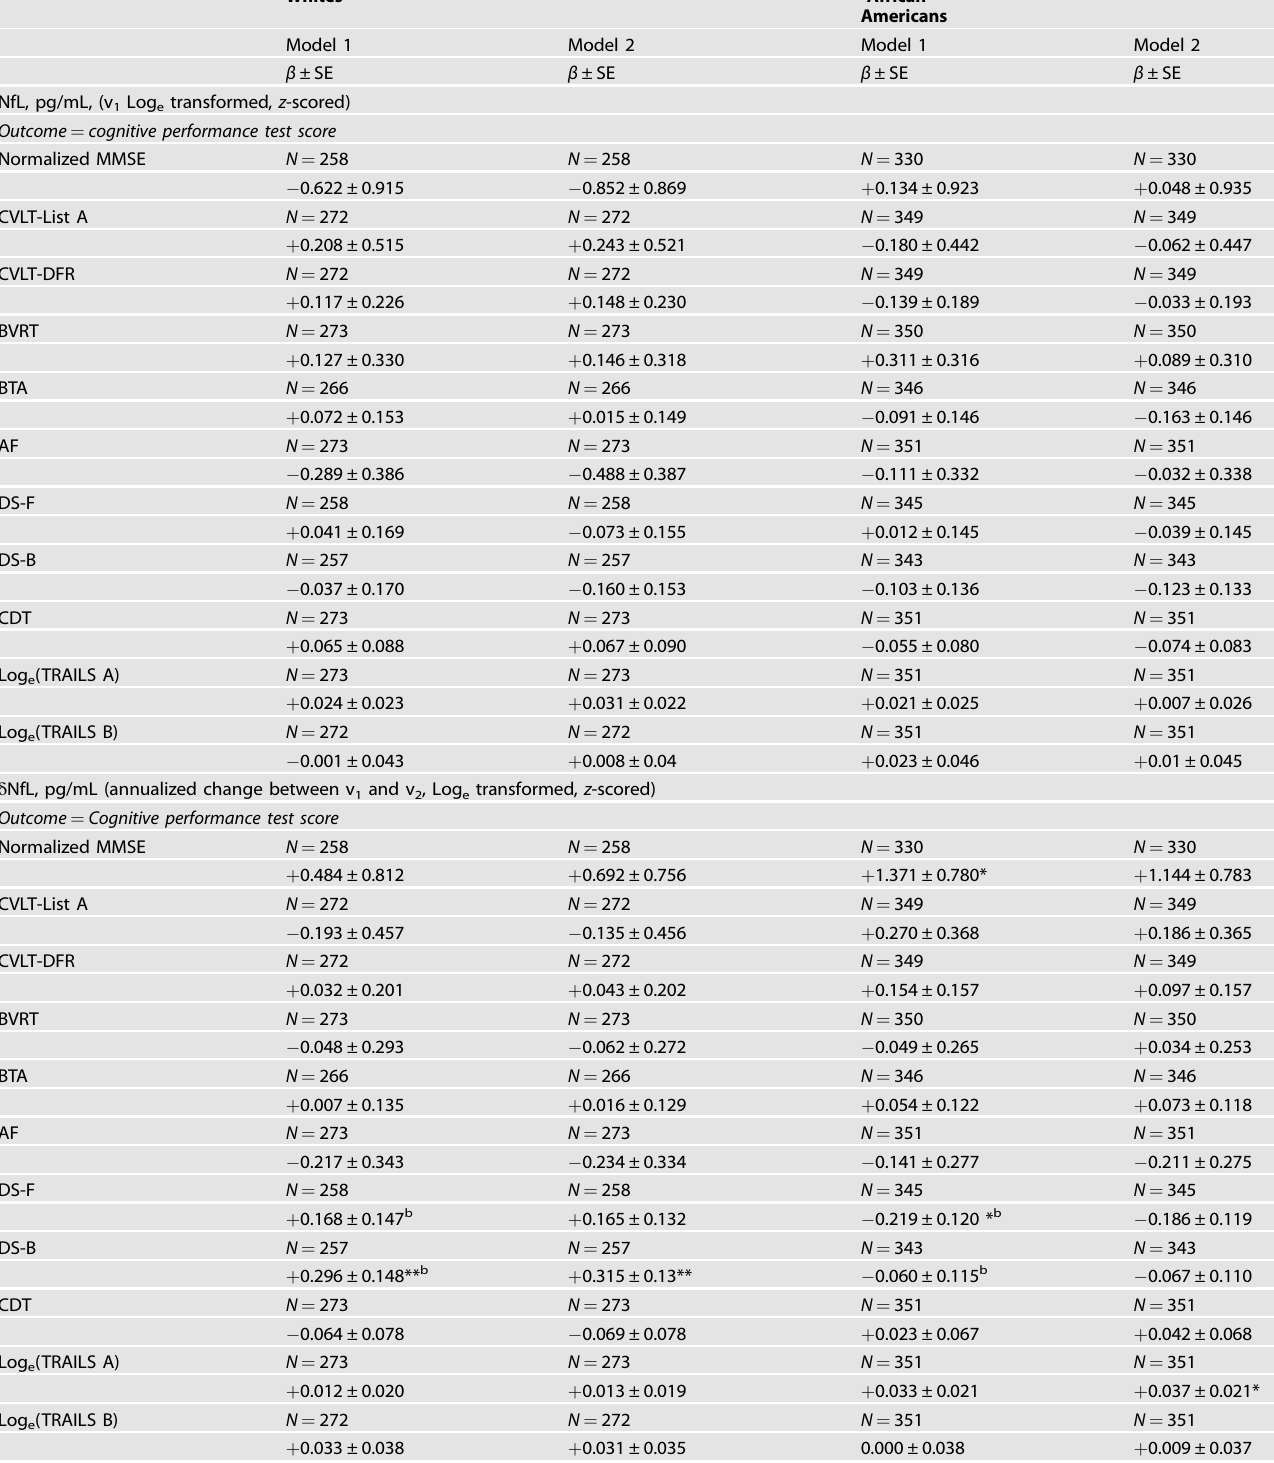
Table 3. Baseline plasma neuro fi lament light (v 1 NfL and δ NfL) and their association with cognitive performance at v 2 : overall and race-speci fi c multiple ordinary least square linear regression models: HANDLS 2004 − 2013 a